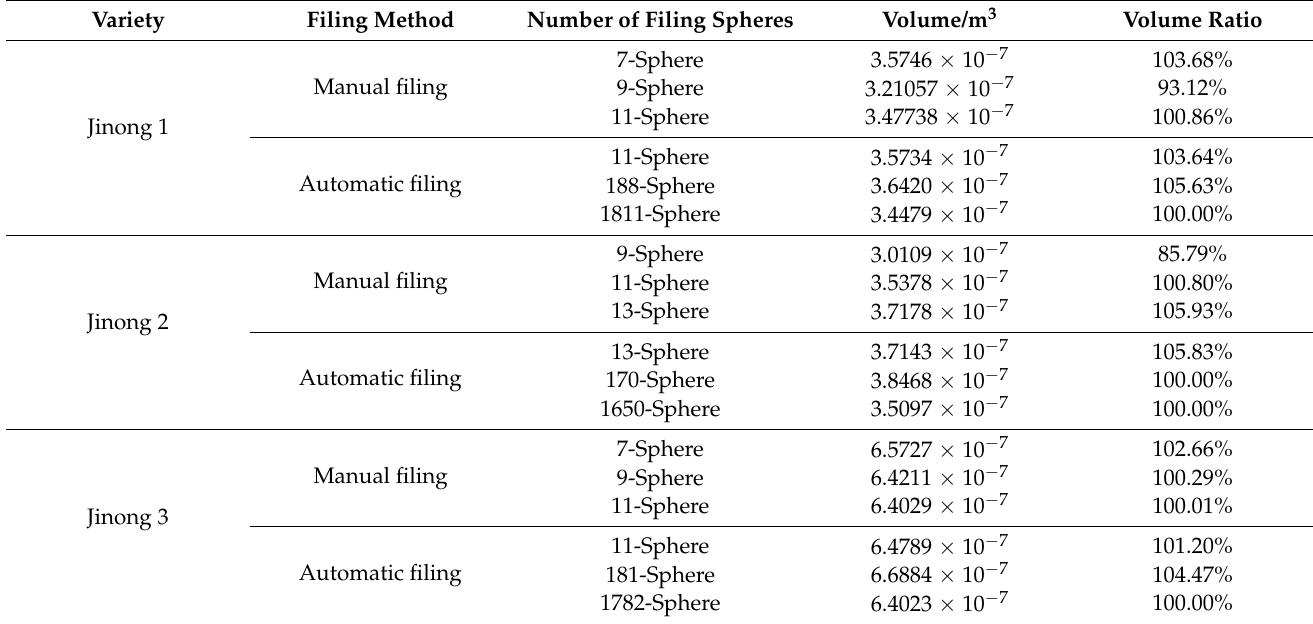
Table 4. Volume and volume ratio for MS models with different numbers of filing